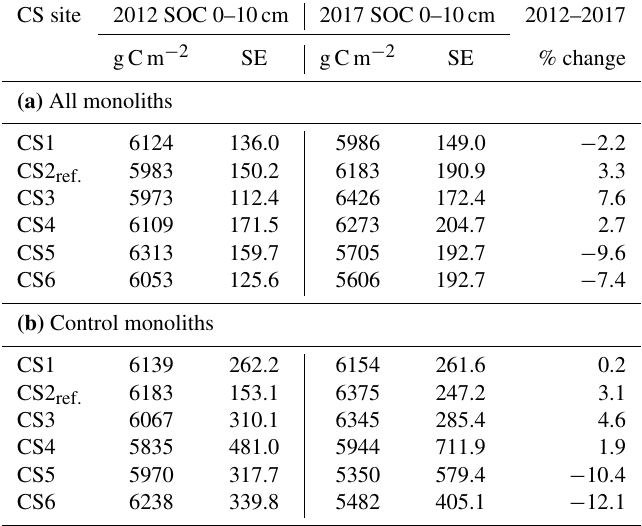
Table 2. SOC stock (gCm − 2 ) at the beginning of the experiment and after 5 years of climate scenario treatment at six climate scenario (CS) sites. Data refer to (a) all monoliths, pooled across the irrigation and N treatments, and (b) control treatment that received neither irrigation nor additional N. SOC in 2012 did not significantly differ among the six CS sites (ANOVA: all monoliths: F 5 , 203 = 2 . 0, P = 0 . 082; control monoliths: F 5 , 25 = 0 . 6, P = 0 .